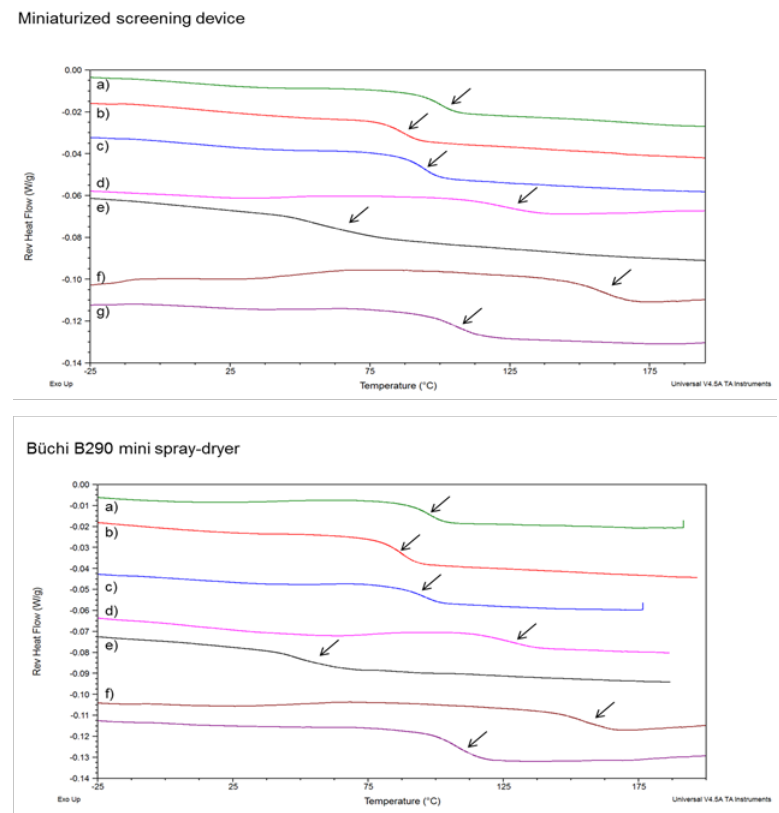
Figure 5. Reverse heat flow signals of 40:60 ( w / w ) SDSDs of itraconazole with HPMCP HP50 ( a ), HPMCAS-LF ( b ), PVPVA ( c ), PVPK30 ( d ), Soluplus ( e ), Eudragit L100 ( f ), and Eudragit L100-55 ( g ) produced by the miniaturized screening device and Büchi B290 mini spray-dryer.